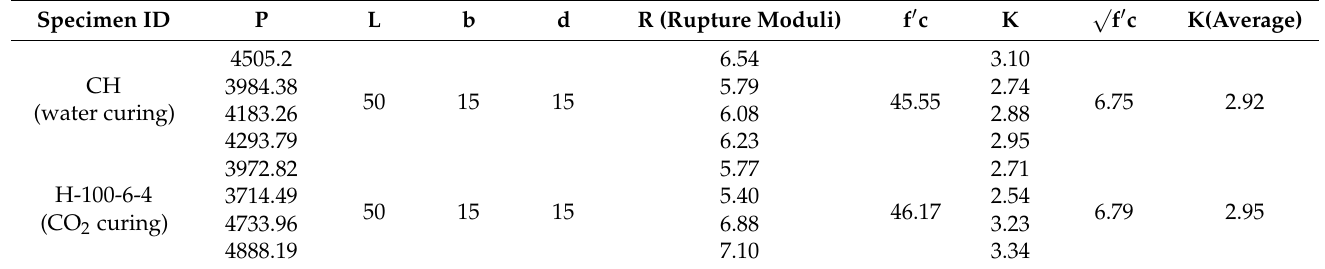
Table 7. Rupture modulus of high strength concrete with CO 2 curing and water